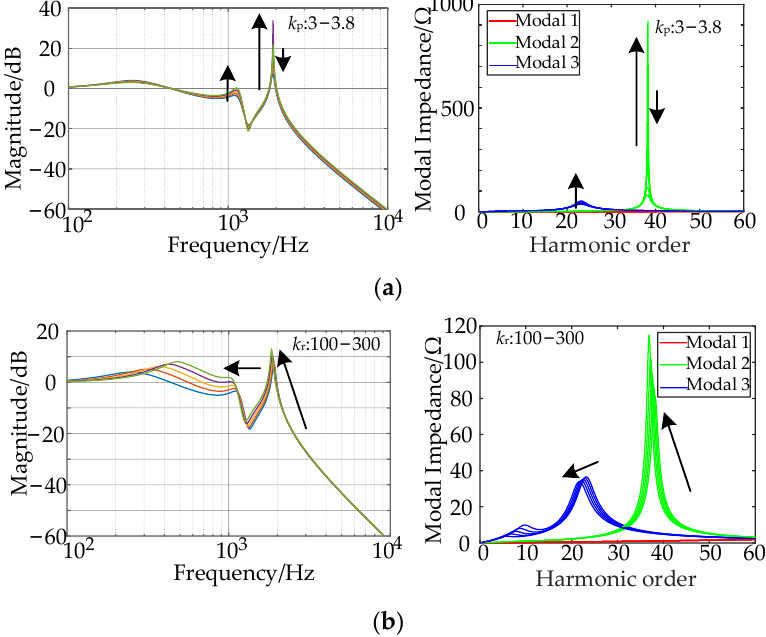
Figure 12. The resonance characteristics curve when the inverter controller parameters are changed: ( a ) k p ; ( b ) k r .